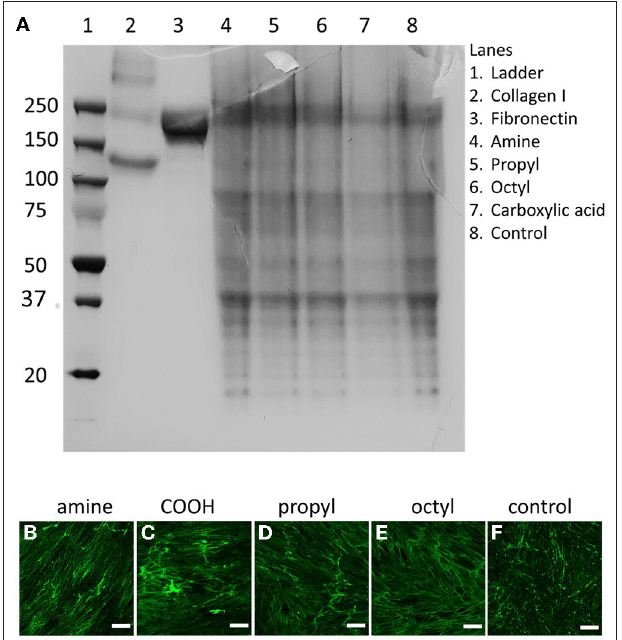
FIGURE 2 | (A) SDS-PAGE and (B–F) confocal microscopy images of dECMs on surfaces with different surface chemistries surface chemistries. Matrices deposited on (B) amine-, (C) carboxylic acid-, (D) propyl-, and (E) octyl-modified surfaces are stained for collagen I, compared to (F) unmodified controls. Scale bars represent 200 µ m.